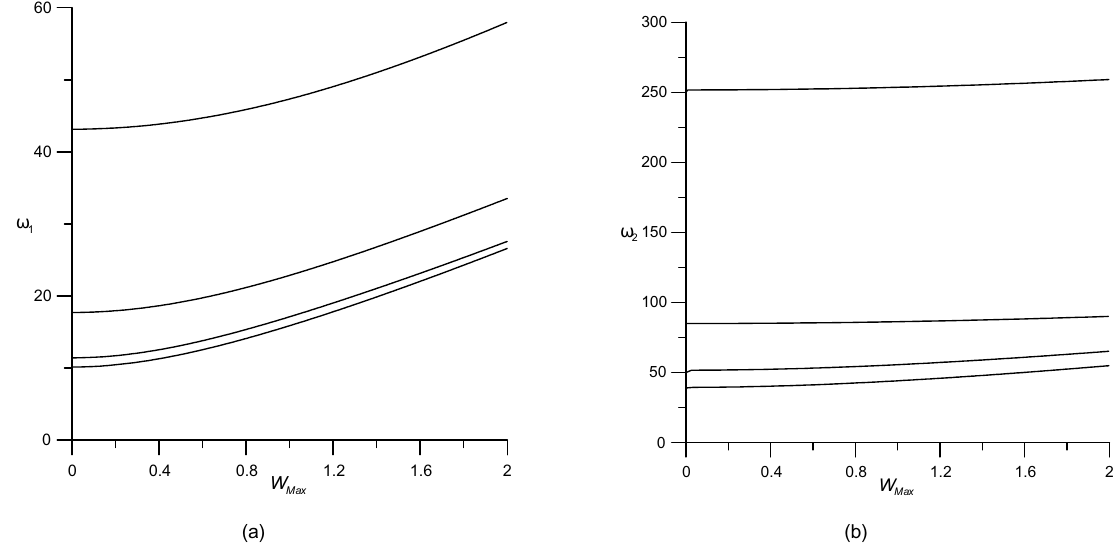
Fig.7. Thefirst(a)and second (b)natural frequencies ofthe plate asfunctions ofthe maximumnondimensional deflection W Max forclamped-free plates of inner radii b = 0 . 1 , 0 . 3 , 0 . 5 , and 0 . 7 . imum nondimensional deflection. Comparison of the results of this case to those of the previous case show significant differences in both the deflection and nat- ural frequency. For a flat plate, the hinged boundary condition produces higher natural frequencies than the corresponding sliding boundary condition for all of the